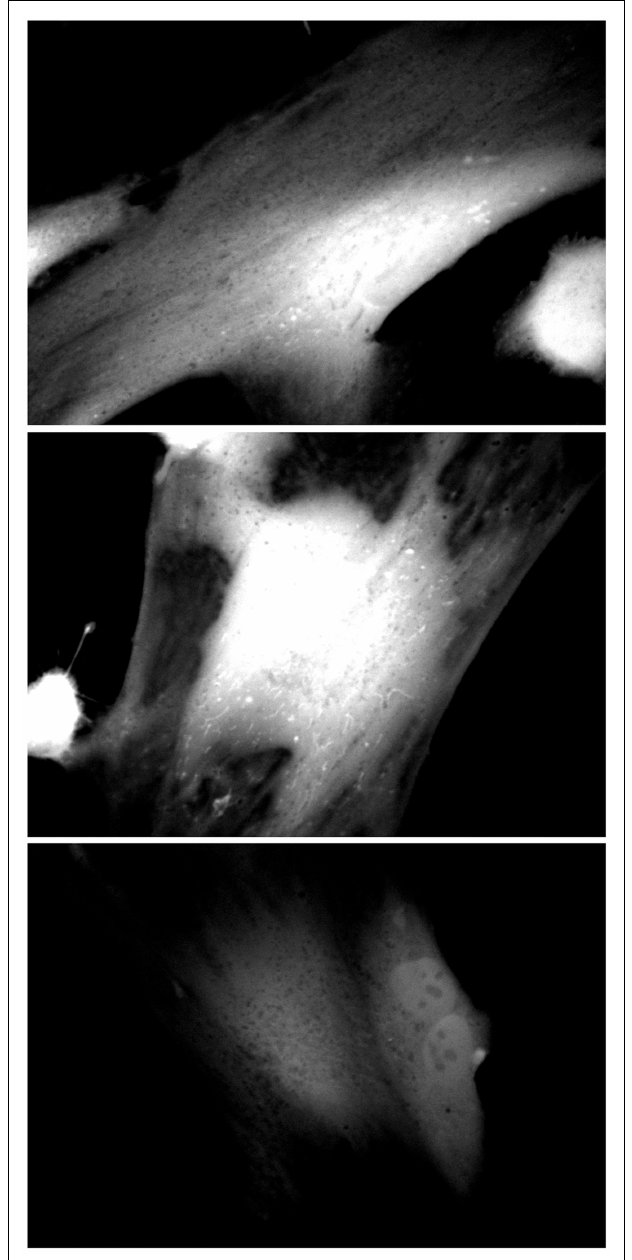
FIGURE 3 | Catalase inhibition increases cellular 2,7-DCF staining. Hs27 fibroblasts were grown in the presence (top two panels) or absence (bottom panel) of 2mM 3-AT for 24h, after which they were treated with the ROS-sensitive dye 2,7-DCF (Invitrogen/Molecular Probes). Cells were live-imaged using confocal microscopy and FITC optics. Images are representative of numerous fields, imaged under identical conditions.